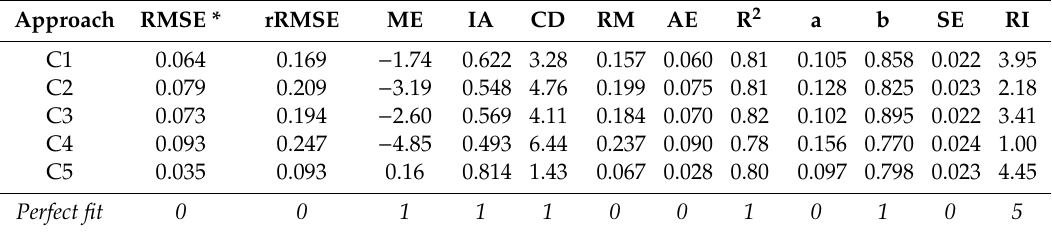
Table 3. Statistical indicators comparing the performance of the five approaches in order to describe the measured soil water content.